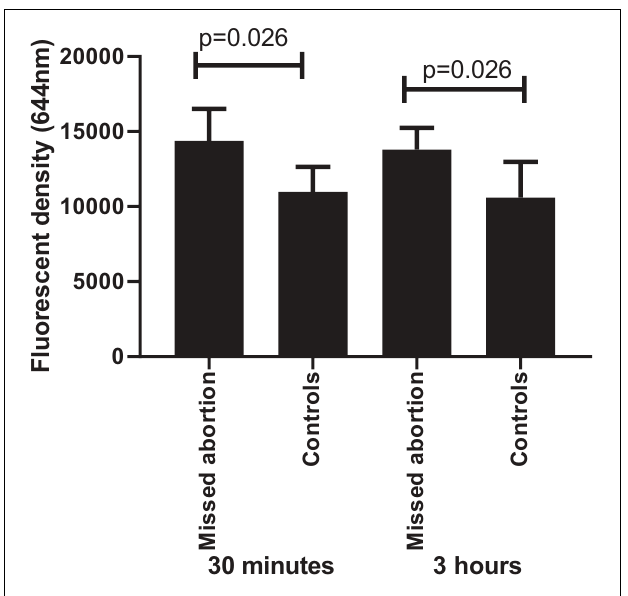
FIGURE 6 | The fluorescent intensity of ROS production showing a significant increase in placental cultures that from missed miscarriage compared to controls, both at 30 min and 3 h ( p = 0.026, p = 0.026, respectively). However, there was no difference in the levels of ROS production between 30 min and 3 h in placental cultures from missed miscarriage ( p =